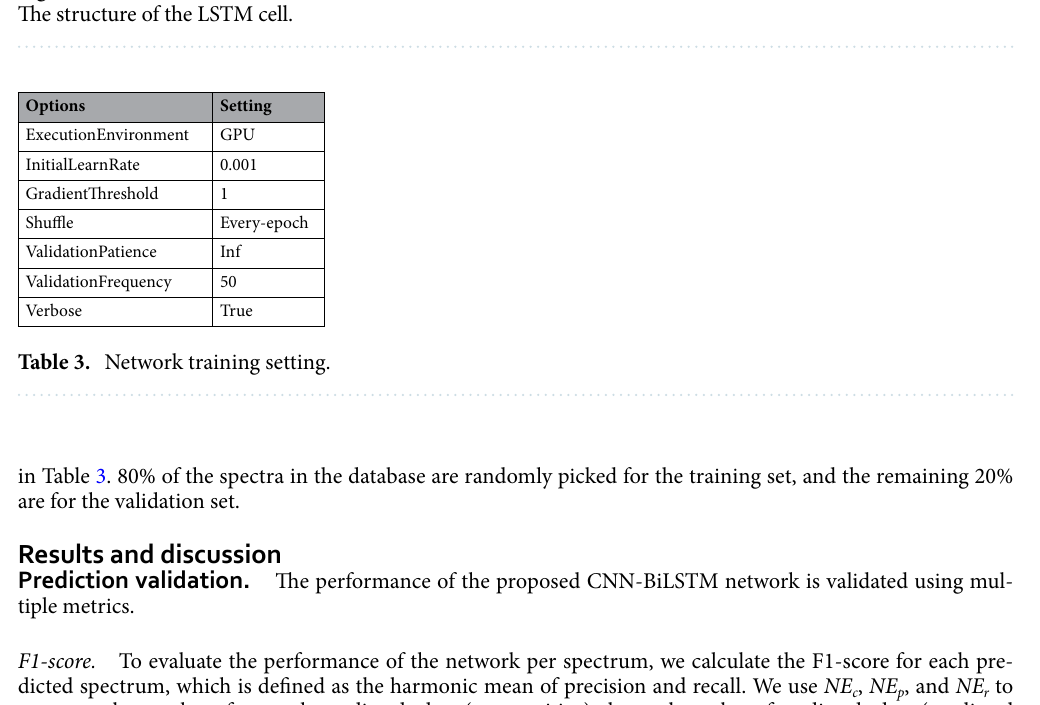
Figure 5. CNN-BiLSTM network architecture. ( a ) The overview. ( b ) The CNN-BiLSTM network structure. ( c ) The structure of the LSTM cell.